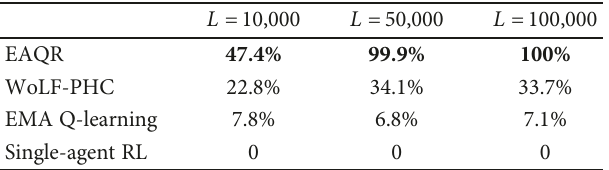
Table 4: Success rate for the DSN problem (evaluation episodes =5000).